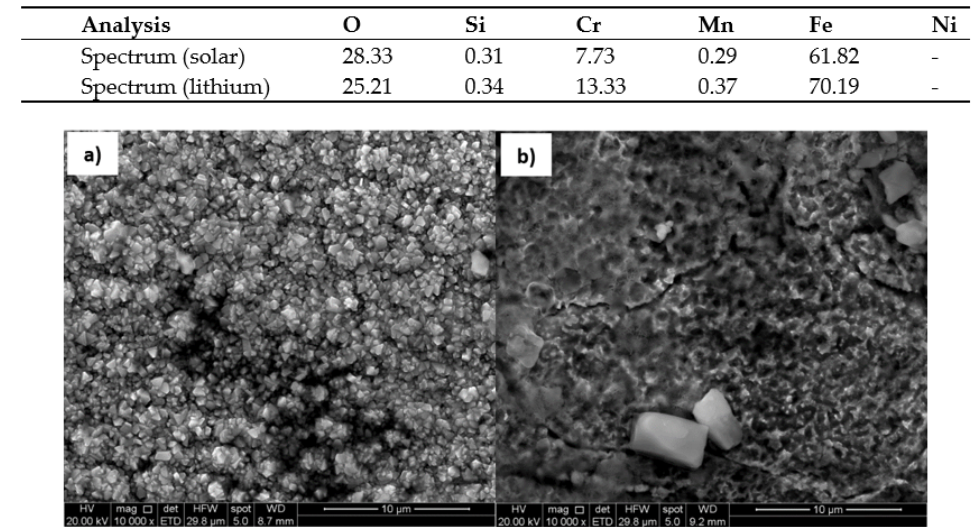
Figure 19. Surface of 430 ferritic stainless steel in ( a ) Solar Salt ( b ) LiNaKNO 3 , at 550 °C after 100 h.